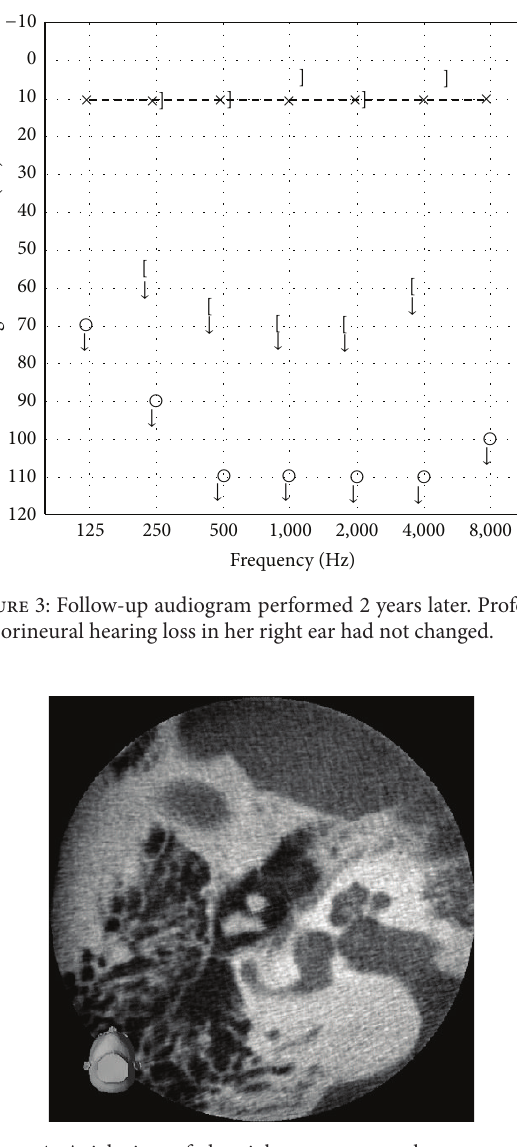
Figure 4: Axial view of the right ear on cone-beam computed tomography obtained 2 years after initial presentation. The air bubble apparent in Figure 2(a) had